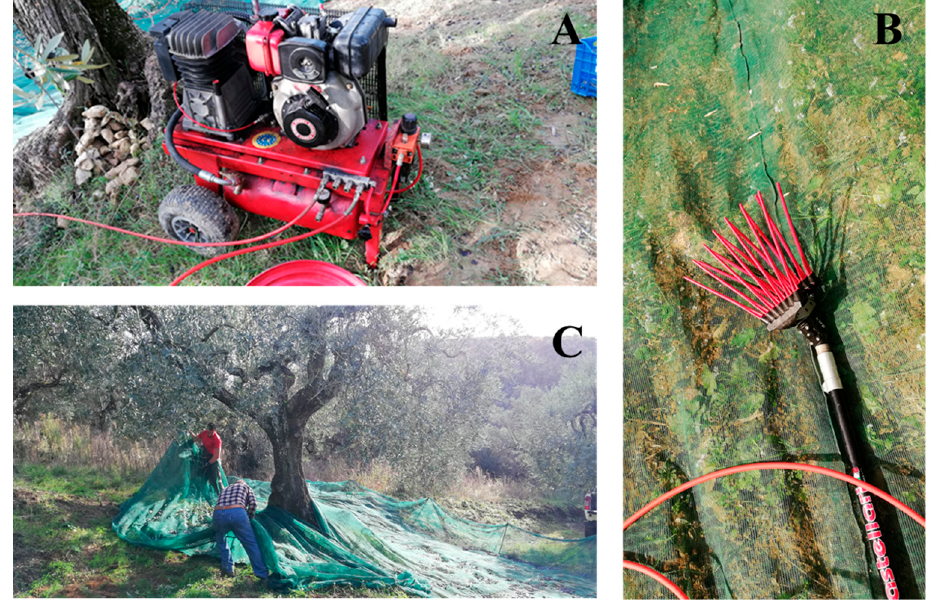
Figure 6. ( A ) Air compressor with 5.5 kW diesel engine; ( B ) pneumatic combs for olive harvesting; ( C ) laying nets for the interception of olives on the ground. Table 1. Main characteristics of the olive trees observed (“Frantoio”